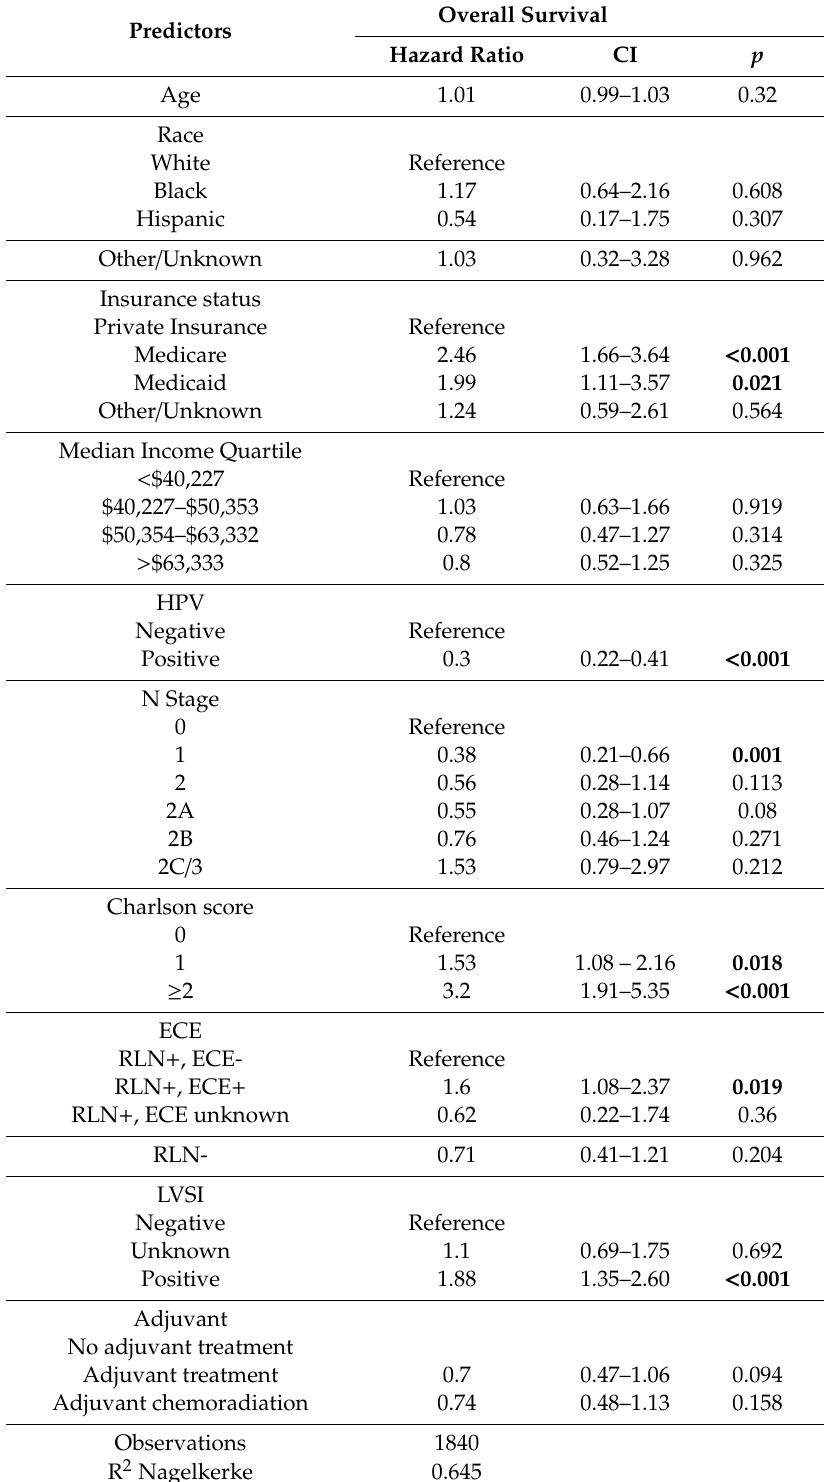
Table 2. Multivariable analysis of predictors of Overall Survival (OS) in TORS-treated